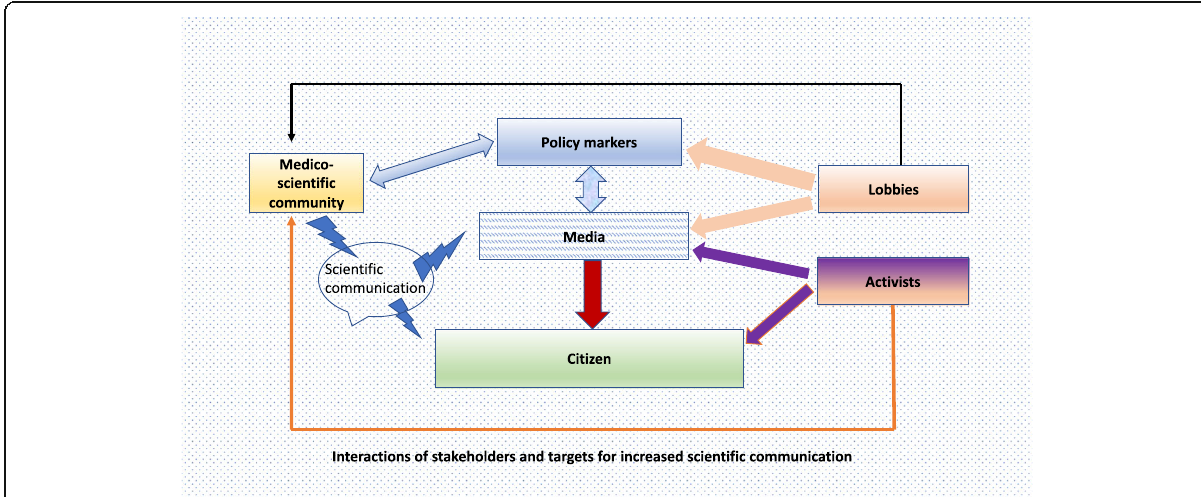
Fig. 1 Interactions of stakeholders and targets for increased scientific